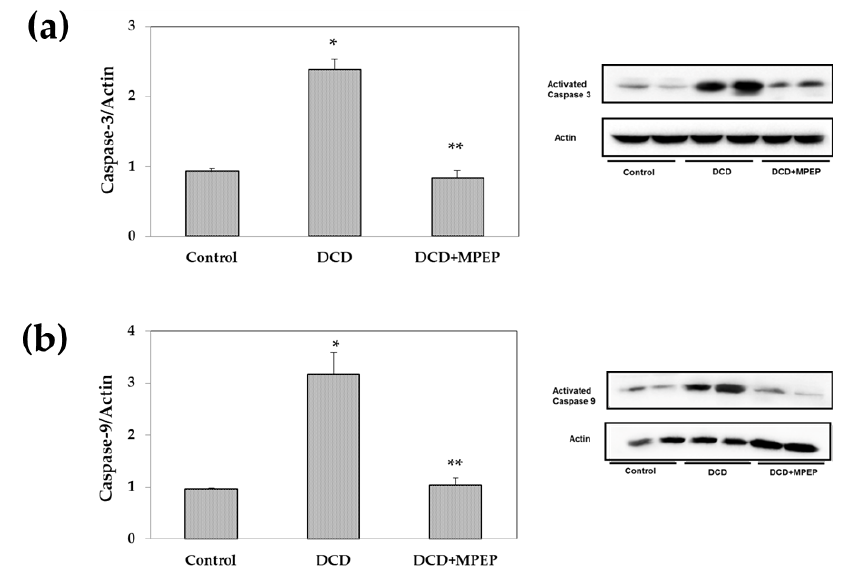
Figure 4. MPEP treatment decreases apoptosis in DCD livers during cold storage. ( a ) Caspase-3 and ( b ) Caspase-9 were determined in livers stored for 22 h in UW solution. Control animals underwent cold storage; in the DCD group, the livers, after 30 min warm ischemia, were submitted to cold storage. In the DCD-MPEP group, the drug (10 mg/Kg) was administered 30 min before the portal clamping and added to the UW solution (3 µM). The results are reported as the mean ±SE. * p < 0.05 versus control; ** p < 0.05 versus DCD.